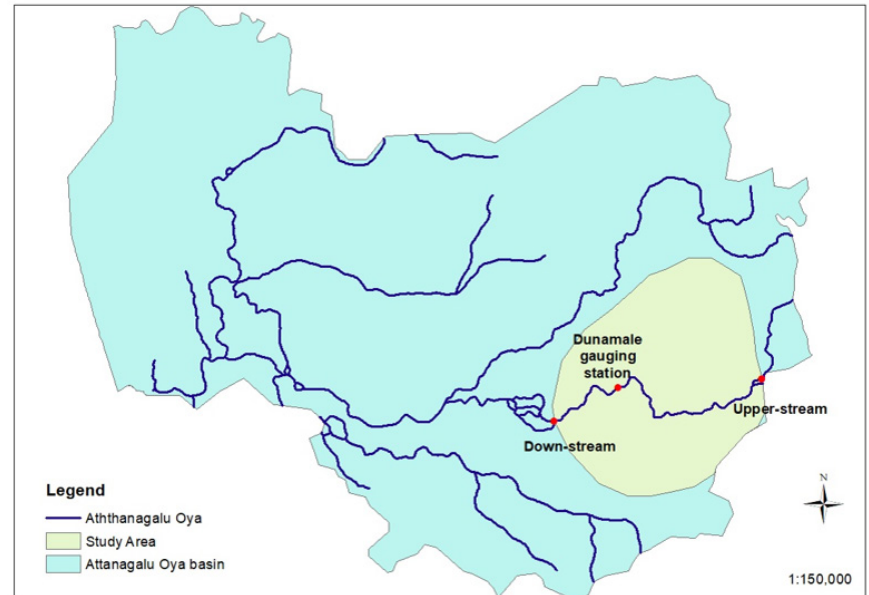
Figure 1: Study area of the Attanagalu Oya